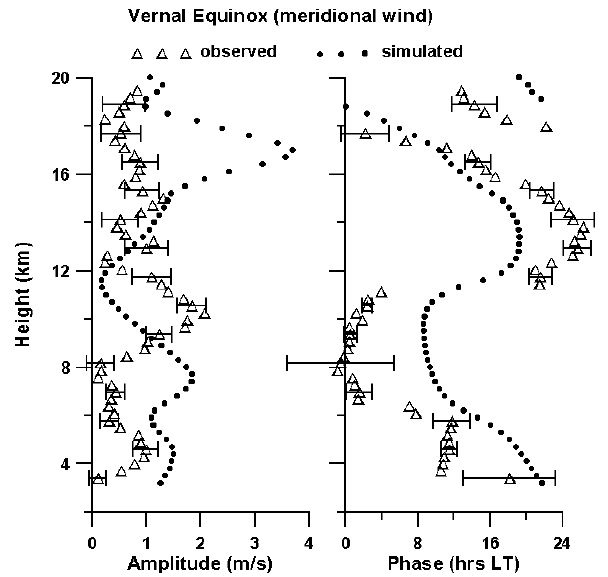
Fig. 6. Same as Fig. 2, but for the vernal equinox season. Fig. 7. Same as Fig. 3, but for the vernal equinox